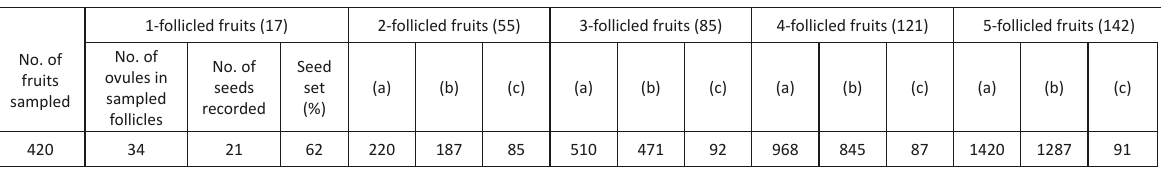
Table 4. Seed set rate in follicled fruits of Hildegardia populifolia 1-follicled fruits (17) 2-follicled fruits (55) 3-follicled fruits (85) 4-follicled fruits No. of fruits sampled